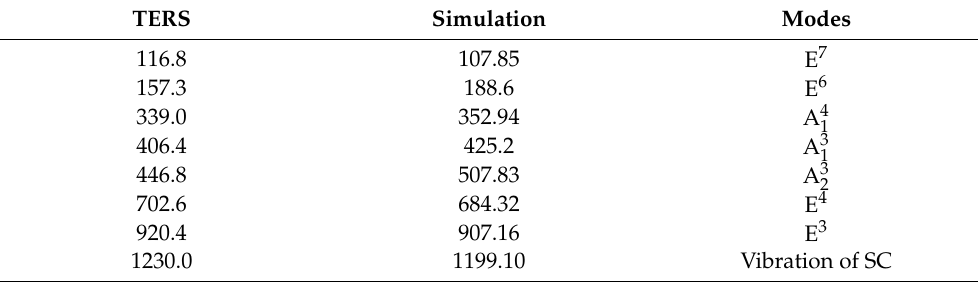
Table 1. TERS modes of the α phase, as compared with the calculation, cm − 1